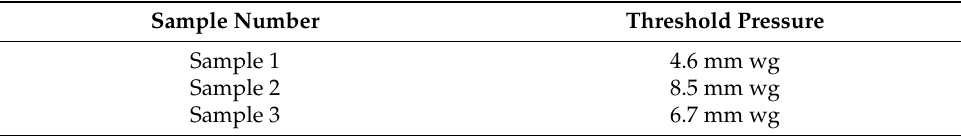
Table 2. Opening pressure for the three tested waterless trap